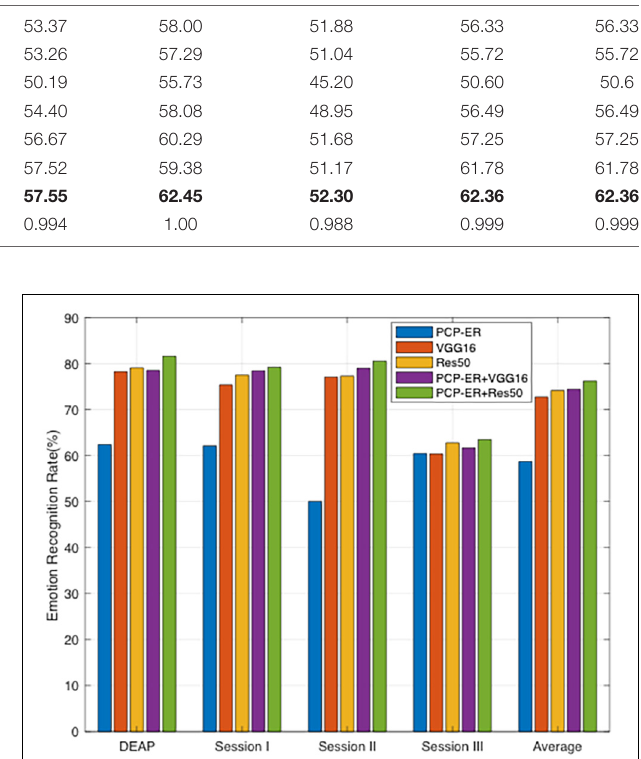
FIGURE 3 | Emotion recognition accuracies (%) of different methods using deeply extracted features.